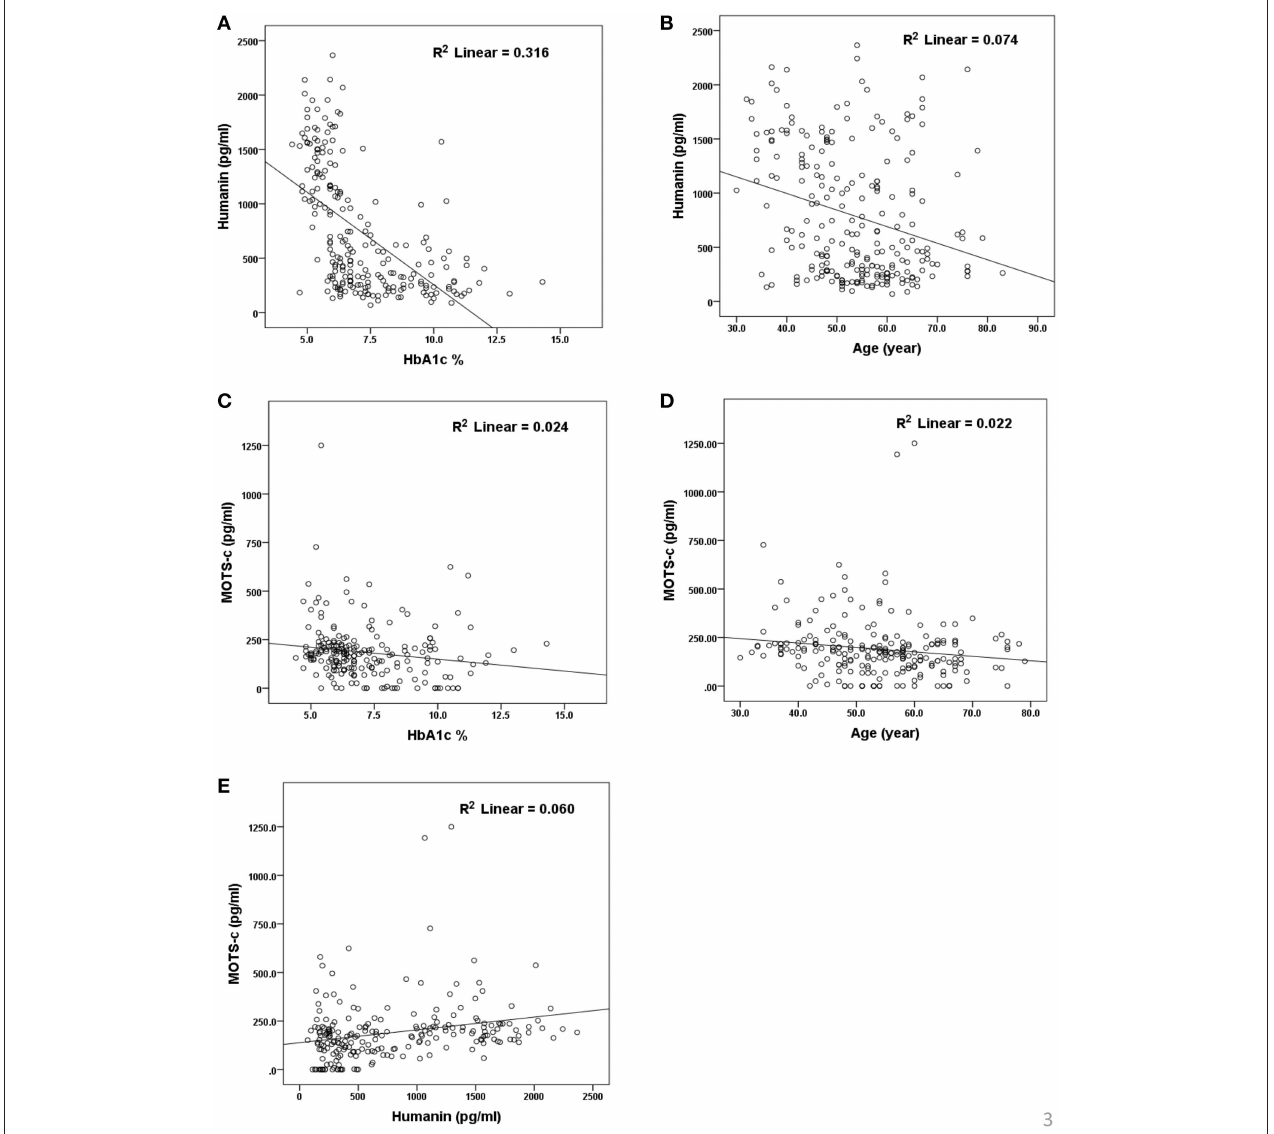
FIGURE 2 | Association of serum HN (A,B) and MOTS-c (C,D) with HbA1C, age and between HN and MOTS-c (E) . HbA1C, glycated hemoglobin. The “ R 2 ” values represent coefficient of determination in linear regression analysis.